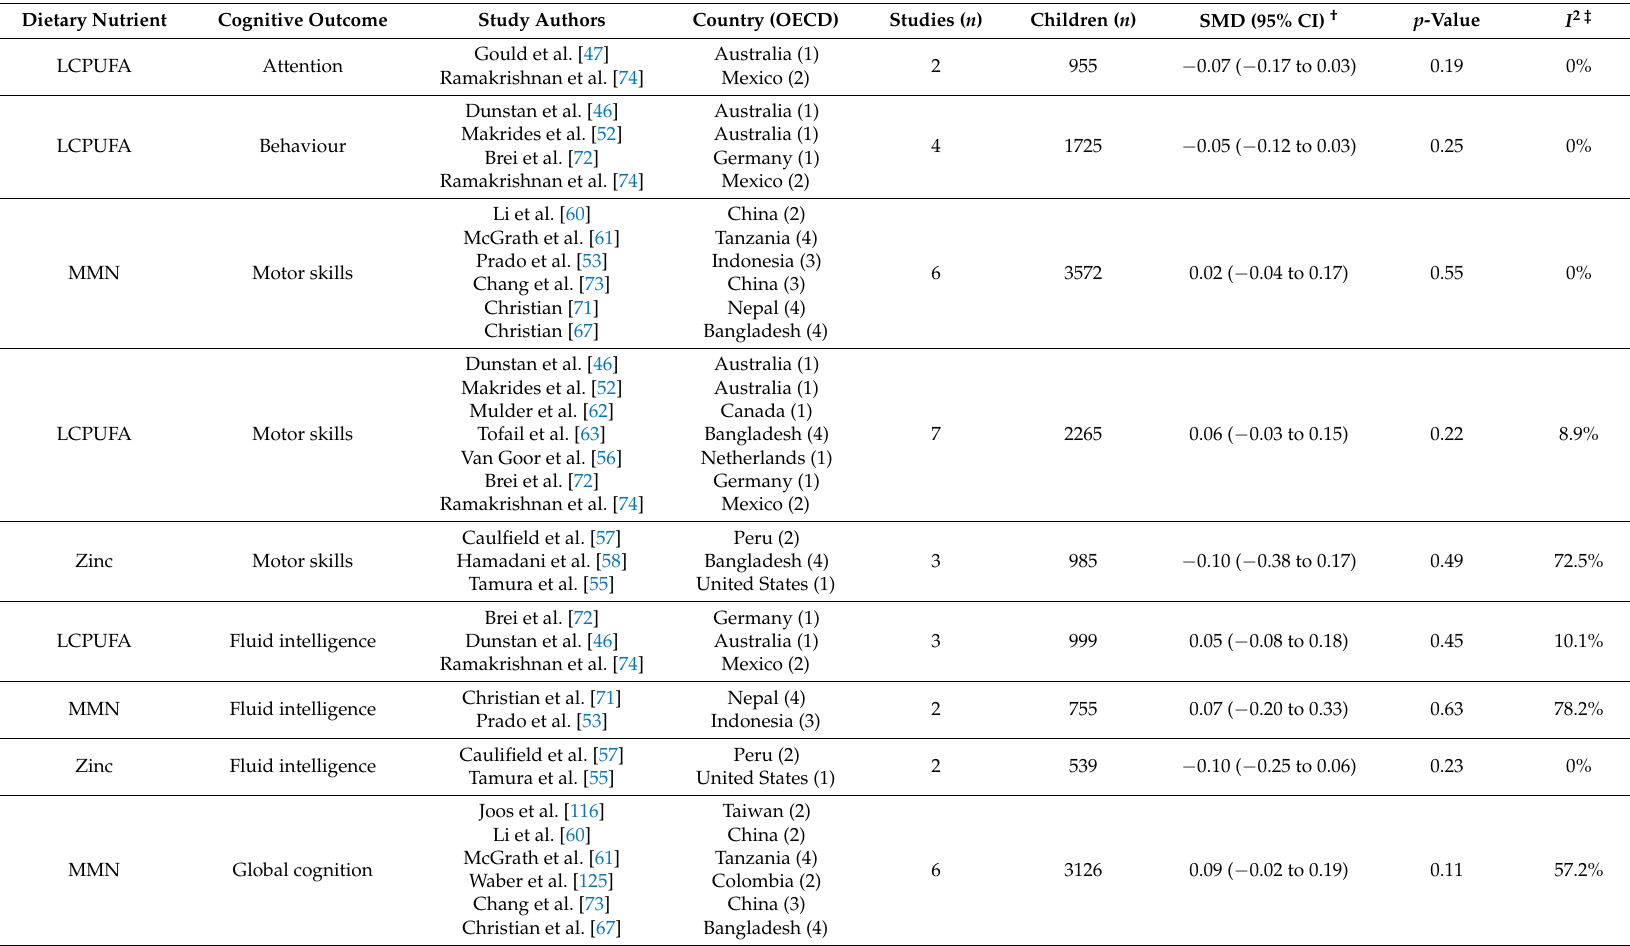
Table 3. Meta-analyses for cognitive outcomes in evaluation of nutritional interventions during